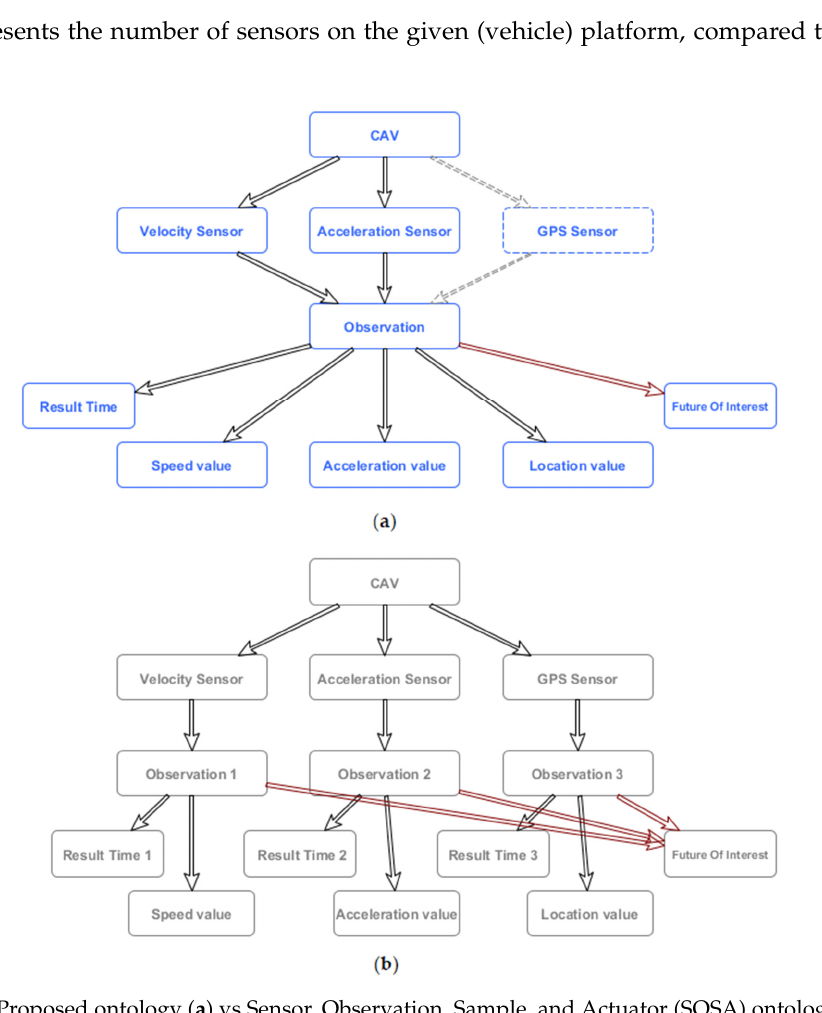
Figure 2. Proposed ontology ( a ) vs Sensor, Observation, Sample, and Actuator (SOSA) ontology ( b ) in simplified